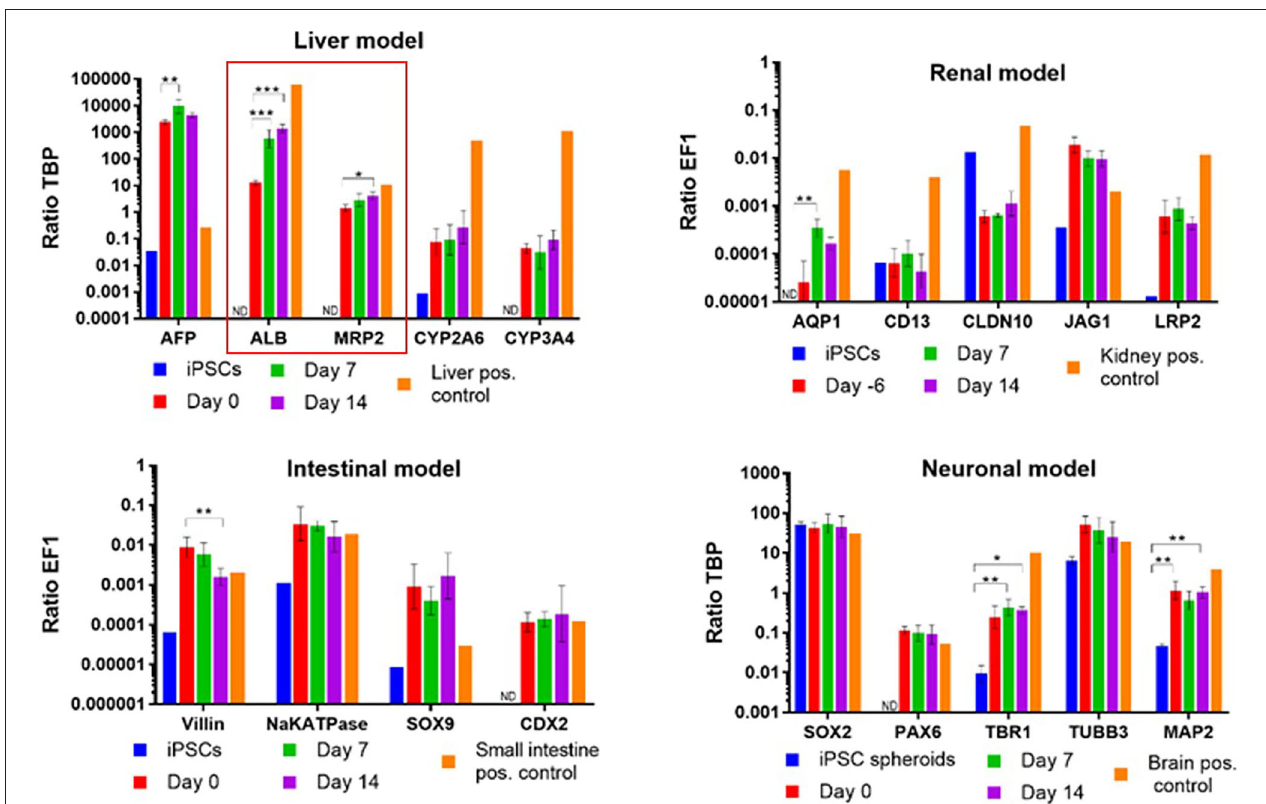
FIGURE 4 | Albumin and MDR2 gene expression increased steadily from day 0 to 14 in a 4-organ chip composed of iPSC-derived premature intestinal, liver, kidney, and neuronal organ models integrated in a physiology-based common media circulation. Feeding of differentiation factor-free medium solely through the intestinal model was performed. One-way ANOVA with Tukey’s multiple comparisons test was used for statistical analysis (* p < 0.05, ** p < 0.01, *** p < 0.001). Data shown as Mean +